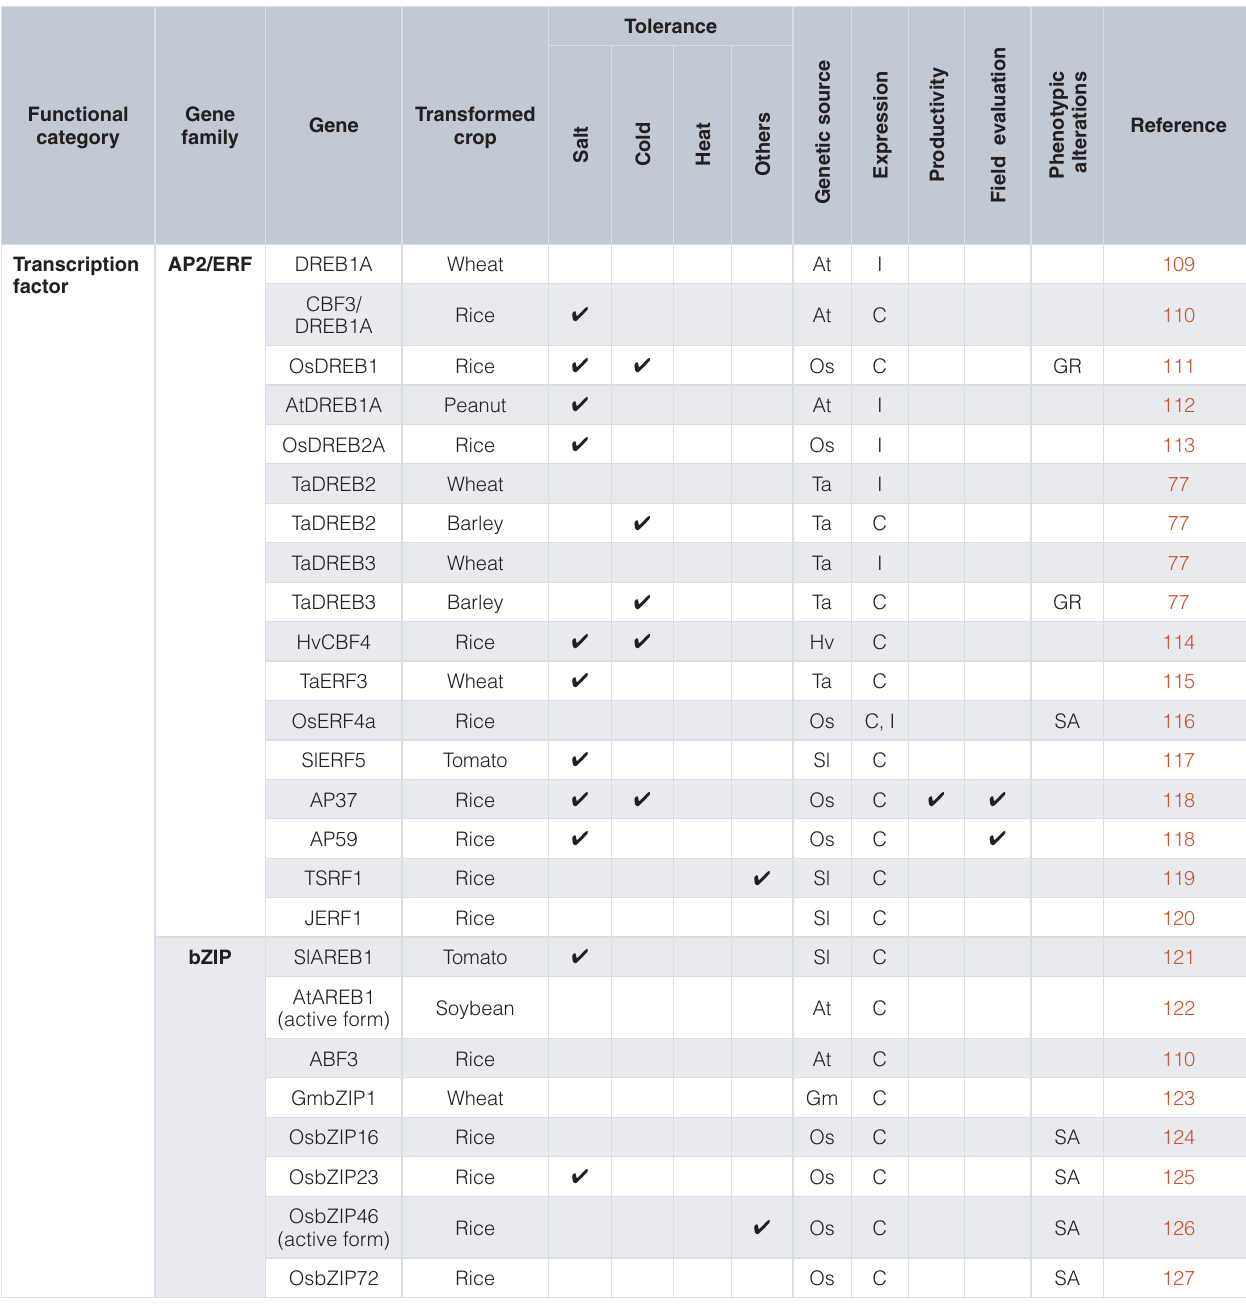
Table 1. Transgenic approaches to improve tolerance to drought and other abiotic stresses. Numerous genes have been shown to improve drought-tolerance in transgenic crops. In addition, some of these approaches have improved productivity and tolerance to other abiotic stresses, such as cold, heat, and high salinity. The gene source and the type of expression system—constitutive (C), inducible (I) or tissue specific (TS)—are indicated in each case. Positive and negative phenotypic alterations are also specified when data are available (GR, growth retardation; IB, increase biomass; PE, pleiotropic effect; SA, sensitivity to ABA; SOx, increased sensitivity to oxidative stress). Gene sources: Arabidopsis thaliana (At), Arthrobacter globiformis (Ag), Bacillus subtilis (Bs), Cynodon dactylon x C. transvaalensis (Cdt), Escherichia coli (Ec), Glycine max (Gm), Gossypium arboreum (Ga), Hordeum vulgare (Hv), Macrotyloma uniflorum (Mu), Malus domestica (Md), Medicago truncatula (Mt), Nicotiana tabacum (Nt), Oryza sativa (Os), Pisum sativum (Ps), Solanum habrochaites (Sh),